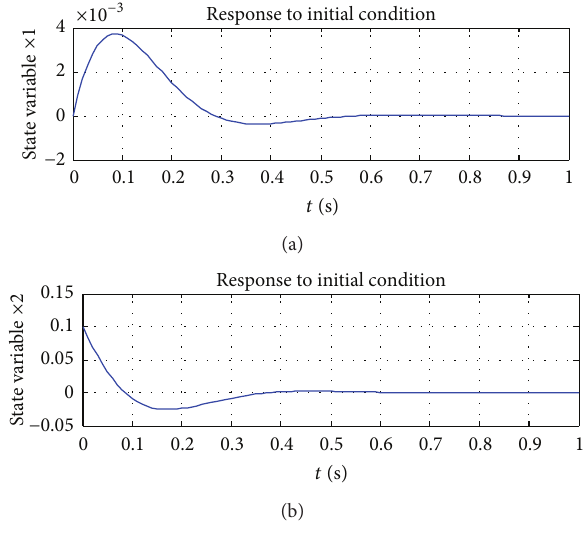
Figure 3: Response to initial